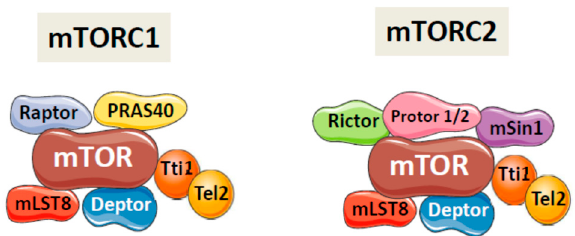
Figure 1. Components of mTORC1 and mTORC2 complexes. mTORC1 and mTORC2 share the core proteins mTOR and mammalian lethal with SEC13 protein 8 (mLST8), the Tti1/Tel2 complex and the inhibitory protein DEP domain-containing mTOR-interacting protein (DEPTOR). In addition, mTORC1 contains regulatory-associated protein of mTOR (Raptor) and the inhibitory subunit proline-rich Akt substrate of 40 kDa (PRAS40), whereas mTORC2 contains rapamycin-insensitive companion of mTOR (Rictor) and the regulatory proteins Protor1/2 and mSin1.